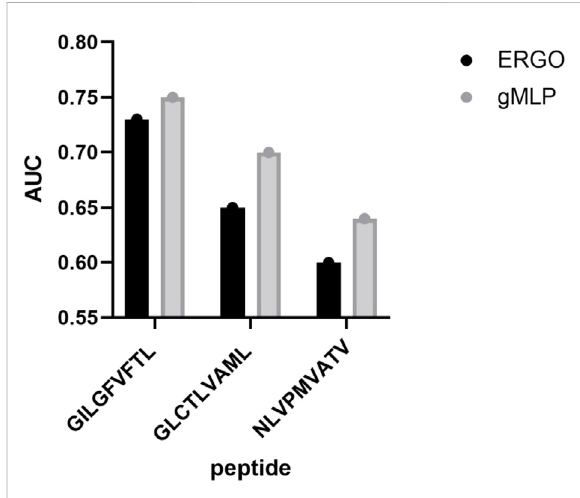
FIGURE 4 Comparison of NetTCR and ERGO-LSTM prediction performance. The AUC of the model on the three most common peptides in the IEDB dataset was compared.